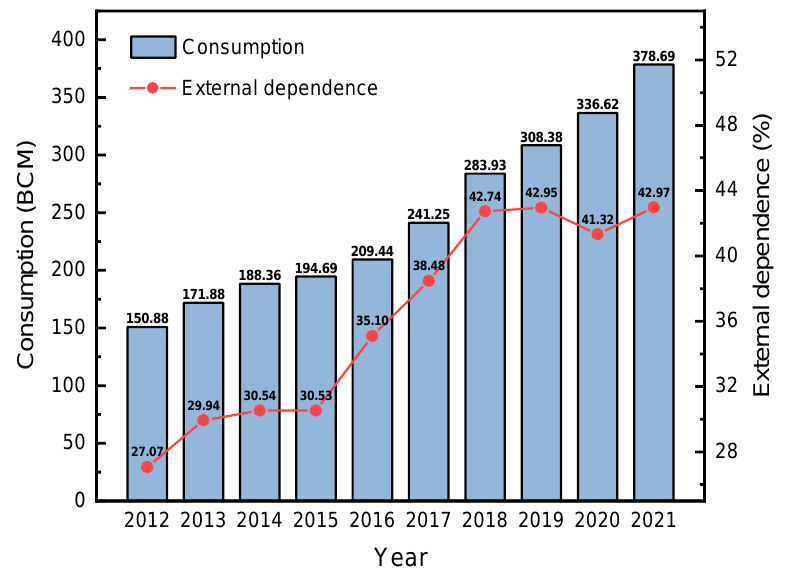
Figure 1. China ’ s natural gas consumption and external dependence in recent 10 years. Figure 1. China’s natural gas consumption and external dependence in recent 10